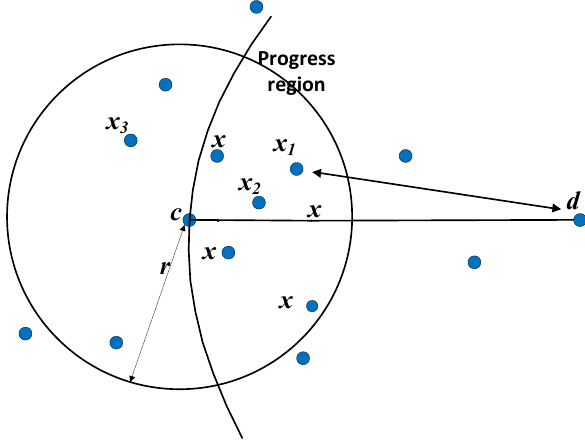
Figure 1 . An instance of the deterministic greedy decision-making by a forwarding node c choosing a neighbour x to relay packets toward the destination d